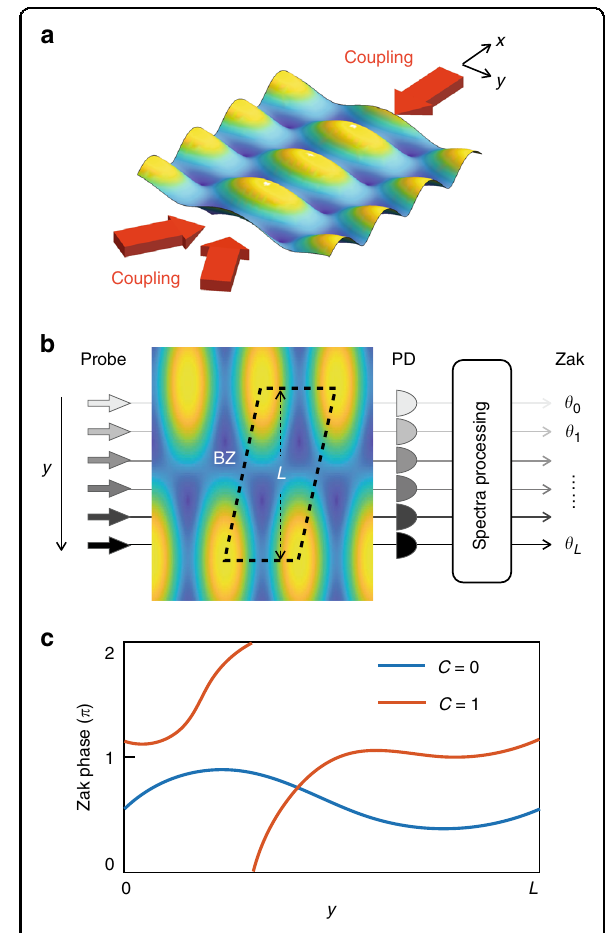
Fig. 5 Proposal of measuring Chern numbers from Zak phases. a 2D interference pattern in x – y plane induced by three coupling fi elds, illustrating the Brillouin zone of a superradiance lattice Haldane model. b Measurement of the position dependent Zak phases. For each fi xed position in y- axis, the θ ± ð y Þ along the x direction is obtained from the absorption spectrum of the corresponding probe fi eld. c The winding number of θ ð y Þ from y ¼ 0 to L is related to the ± Chern number C , where L is the BZ width projected on y